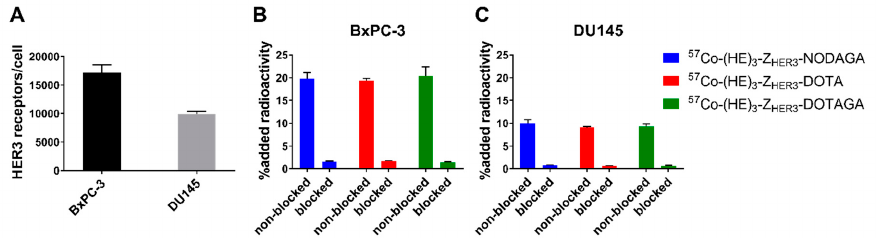
Figure 2. Receptor quantification and in vitro specificity. ( A ) HER3 expression was quantified for BxPC-3 (n = 2) and DU145 (n = 2) cells by incubation with [57Co]Co-(HE)3-ZHER3-NOTA until saturation. For the in vitro specificity test in ( B ) BxPC-3 and ( C ) DU145 cells, binding to HER3 was inhibited by addition of 50 nM HER3 binding a ffi body in the blocked groups. Specificity data is presented as the average of three dishes ± SD.